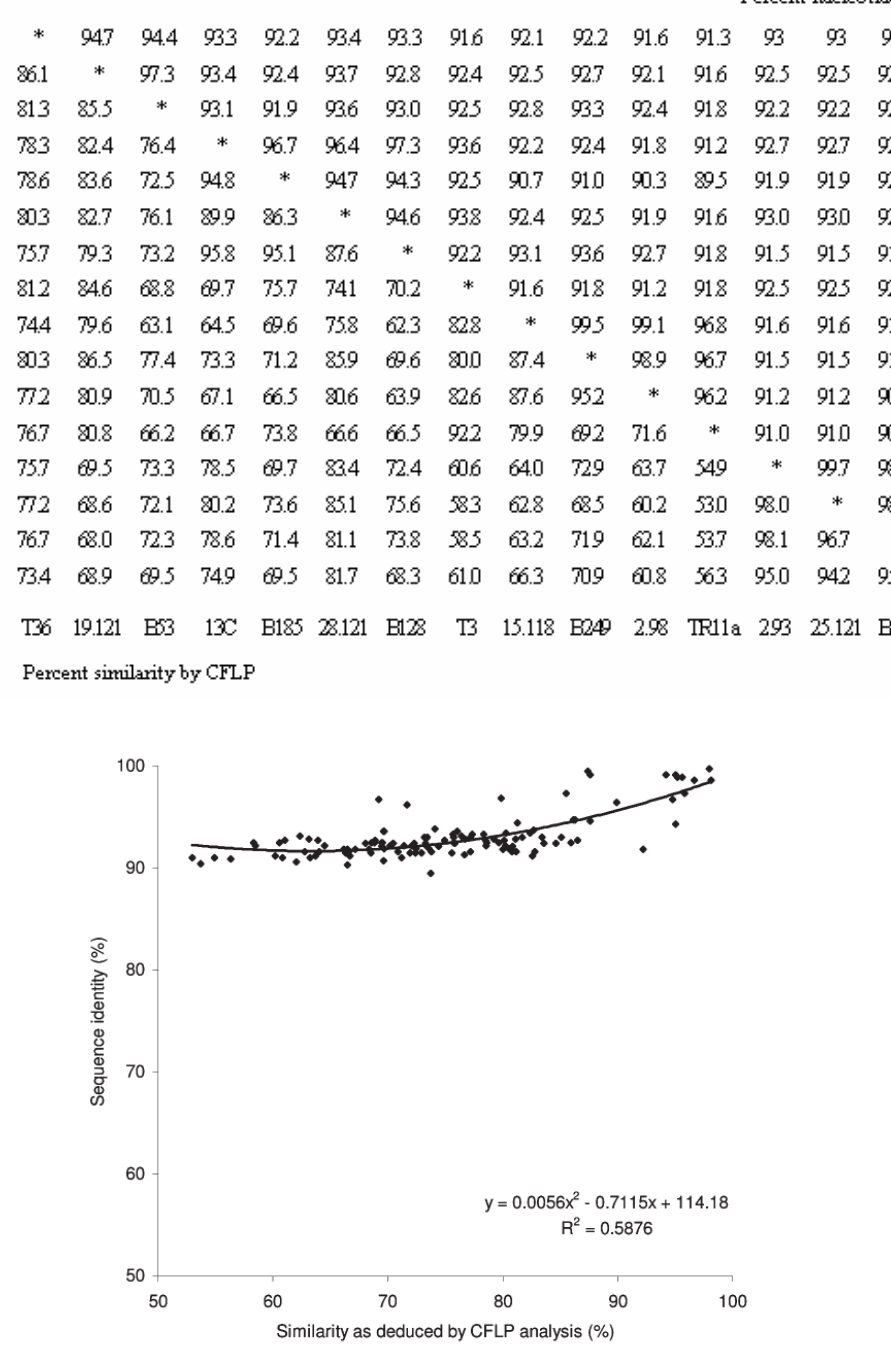
Table 3. Percent nucleotide identity obtained from sequence data (above diagonal) and percent similarities as esti-